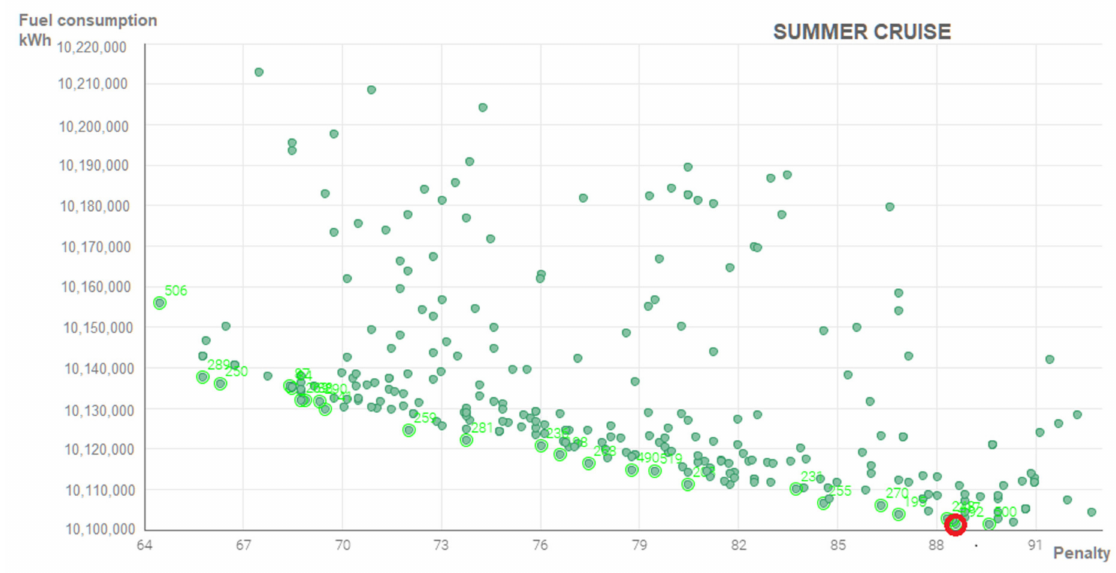
Figure 11. Pareto front of the optimal solutions in the summer case. The red circle indicates the most interesting solutions from the point of view of reducing consumption.